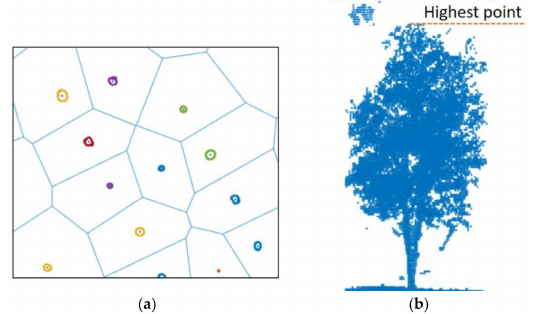
Figure 12. Total tree height (TH) estimation. ( a ) Voronoi polygons for each trunk center; ( b ) Voxel centroids inside a vertical prism for each Voronoi polygon and the highest point of the tree.